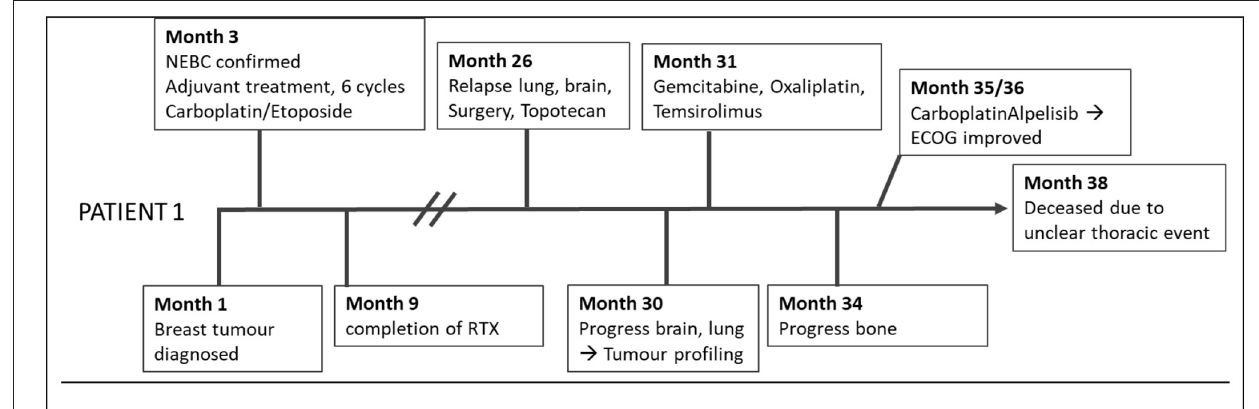
FIGURE 1 | Timeline of patient 1.